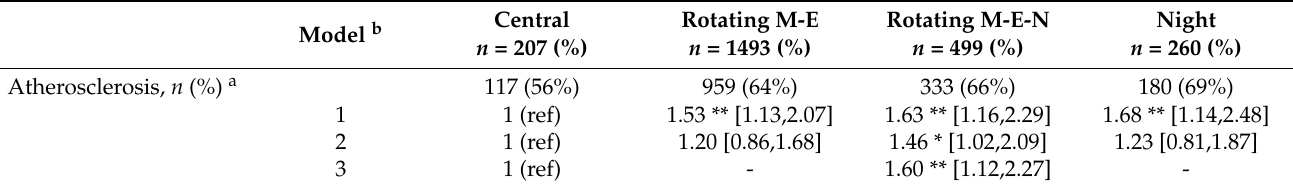
Table 3. Odds of subclinical atherosclerosis (presence of plaque in the femoral or carotid territories) by work shift in the AWHS